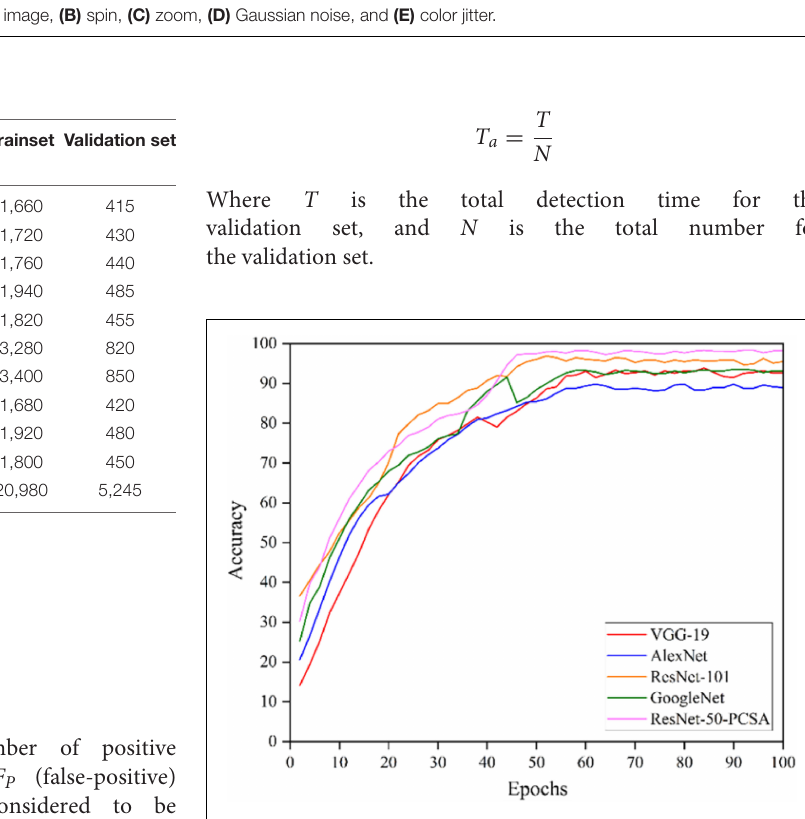
FIGURE 8 | The training accuracy